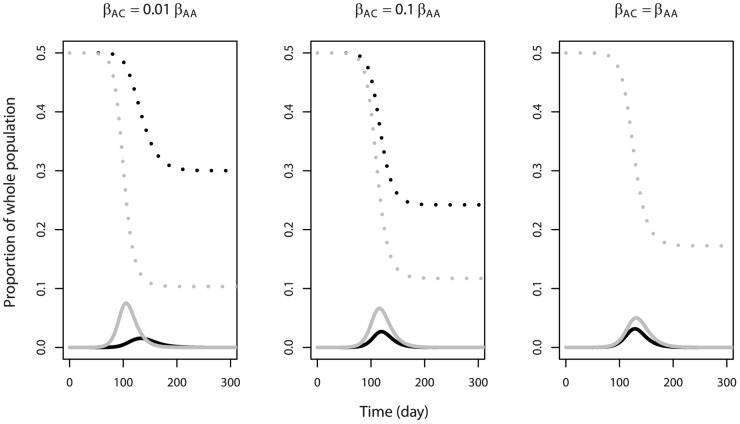
Time series of a simulated epidemic in a population in which transmission between adults (black) and children (gray) is 1% of intra-group transmission (βAC = 0.01 * βAA; βCA = 0.01 * βCC; left), or 10% (βAC = 0.1 * βAA; βCA = 0.1 * βCC; middle), or 100% (βAC = βAA; βCA = βCC; right), in the absence of intervention.Broken line: susceptible; solid line: infected. In the right panel, the black and gray broken lines overlap each other exactly. R0A = 1.25; R0C = 2. 50% adults; 50% children. All other parameters and initial conditions are listed in Tables 1 and 2. The reason why in the right panel, the curves of susceptible adults and children overlapped, while the curves of infected adults and children did not, was that adults and children had different rates of recovery and therefore their average durations in the model compartment of the infected/infectious were different.